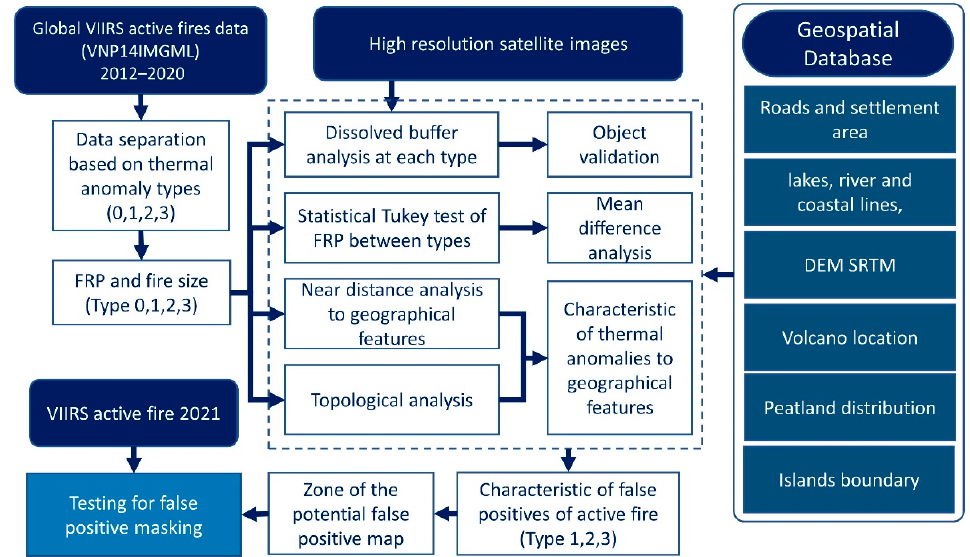
Figure 1. Flowchart of the workflow for mapping the false positives of active fires using VNP14IMGML data.